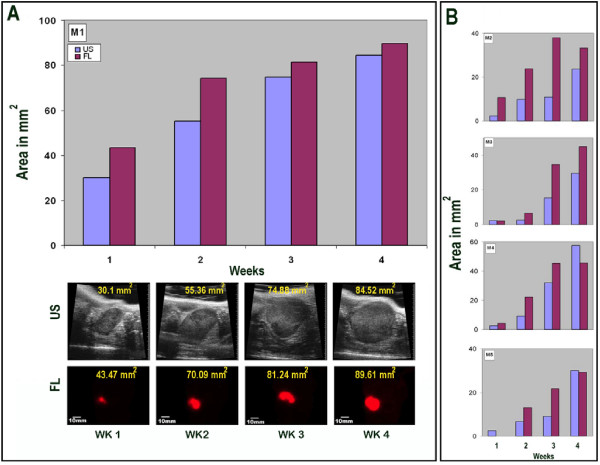
Comparison of whole body fluorescence imaging and ultrasound imaging to monitor tumor growth over time in individual mice. Whole-body fluorescence and ultrasound images were obtained on a weekly basis for a period of four weeks. Tumor measurements were determined as explained in the legend for Figure 2. A. The graph shows the growth of an orthotopic pancreatic-tumor implant in a single mouse (M1) as assessed by both whole-body fluorescence (FL) and ultrasound (US) imaging. The four corresponding ultrasound (upper row) and color fluorescence (lower row) images are shown below the graph with the calculated tumor sizes (mm2) for each image indicated. B. Graphical depictions of tumor growth over a four week period for an additional four mice (M2 thru M5) with orthotopic pancreatic tumor implants. Bar graphs shown in this figure depict single measurements taken at weekly timepoints. The graphs demonstrate a strong correlation between whole-body fluorescence and ultrasound imaging modalities for determination of tumor size.